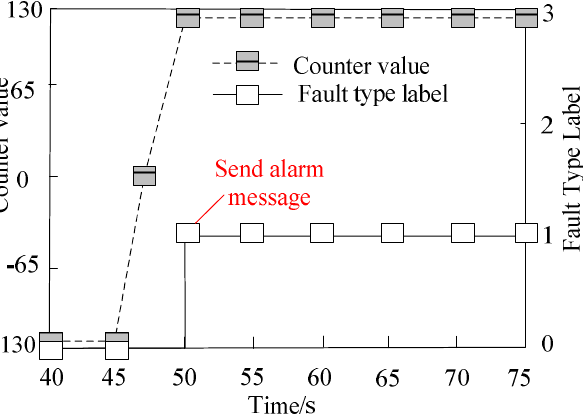
Figure 11. Real-time alarm results for engine operation faults by the proposed method.